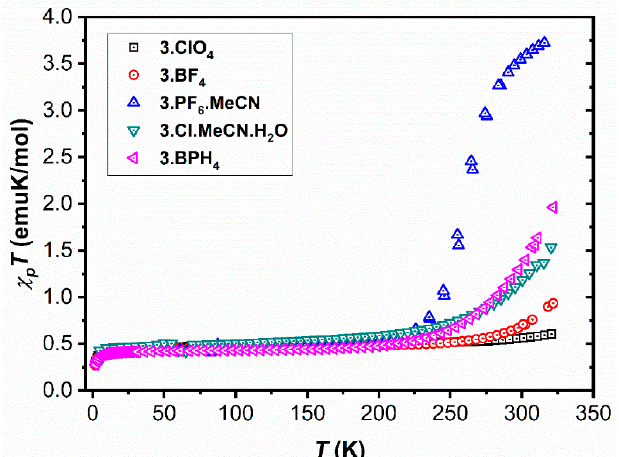
Figure 2. Temperature dependence of the χ P T product in a field of 1 T.